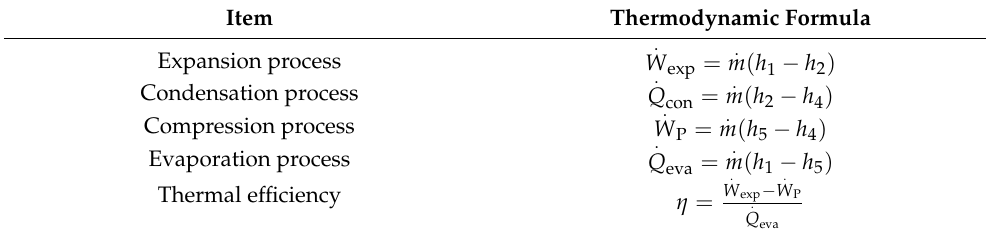
Table 6. Formula of ORC